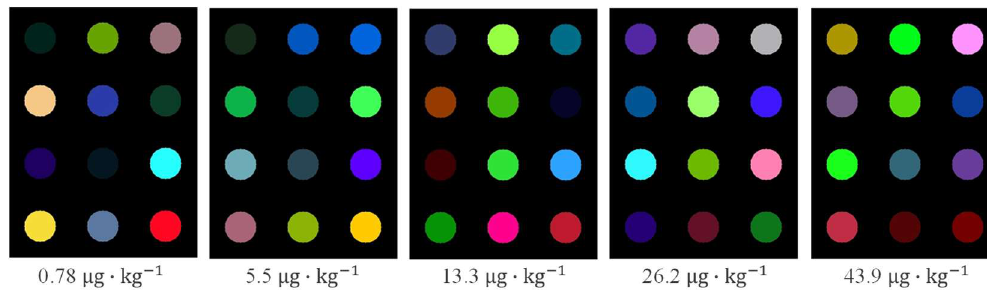
Figure 1. Difference image of peanut colorimetric sensor with different mildew degree.